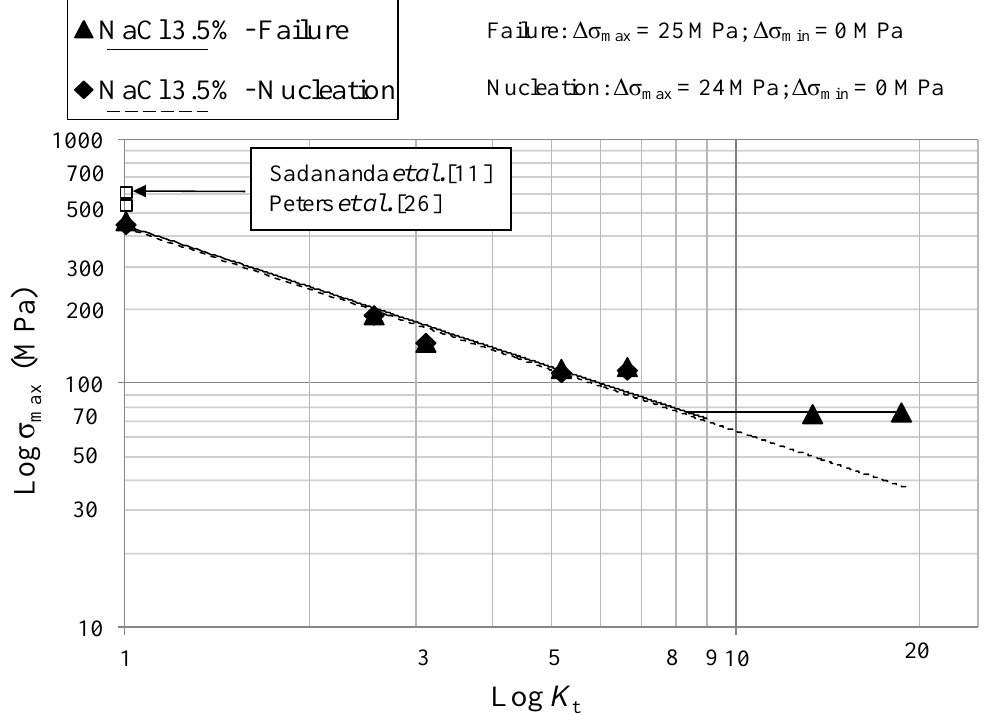
Figure 13. Log-limiting maximum stress ( R = 0.1, 10 Hz) at initiation and failure vs . Log- K at a constant life of 200,000 cycles for the samples tested in NaCl 3.5 t